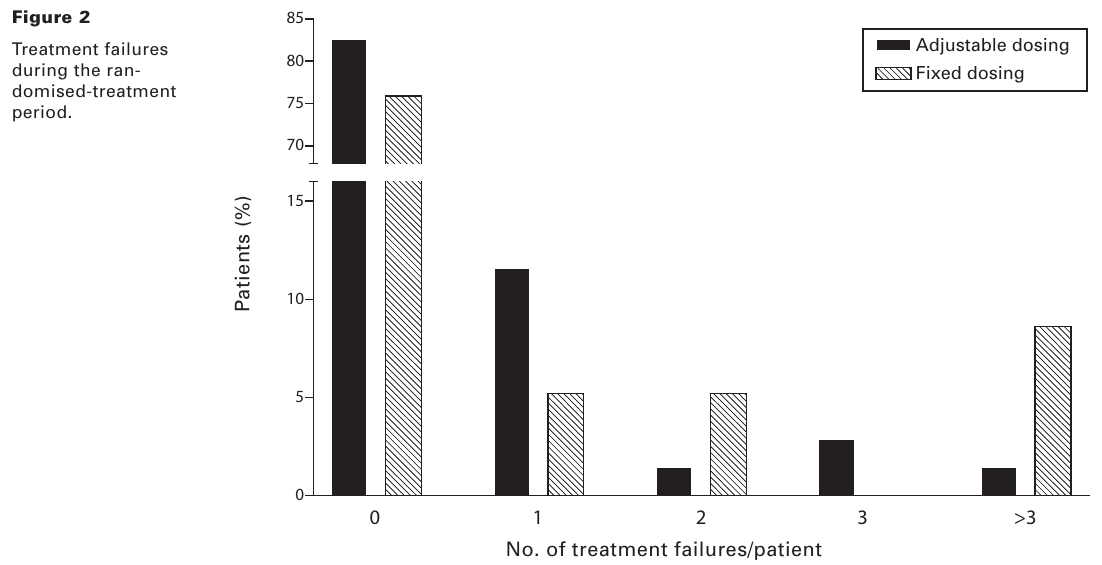
Asthma symptom severity (NHLBI severity level) at start of run-in and end of treatment for the ad- justable- and fixed- dosing groups. After 12 weeks of treat- ment asthma severity decreased in both groups. However, the change was only sig- nificant in the ad- justable-dosing group (p = 0.0039 vs. p = 0.11).